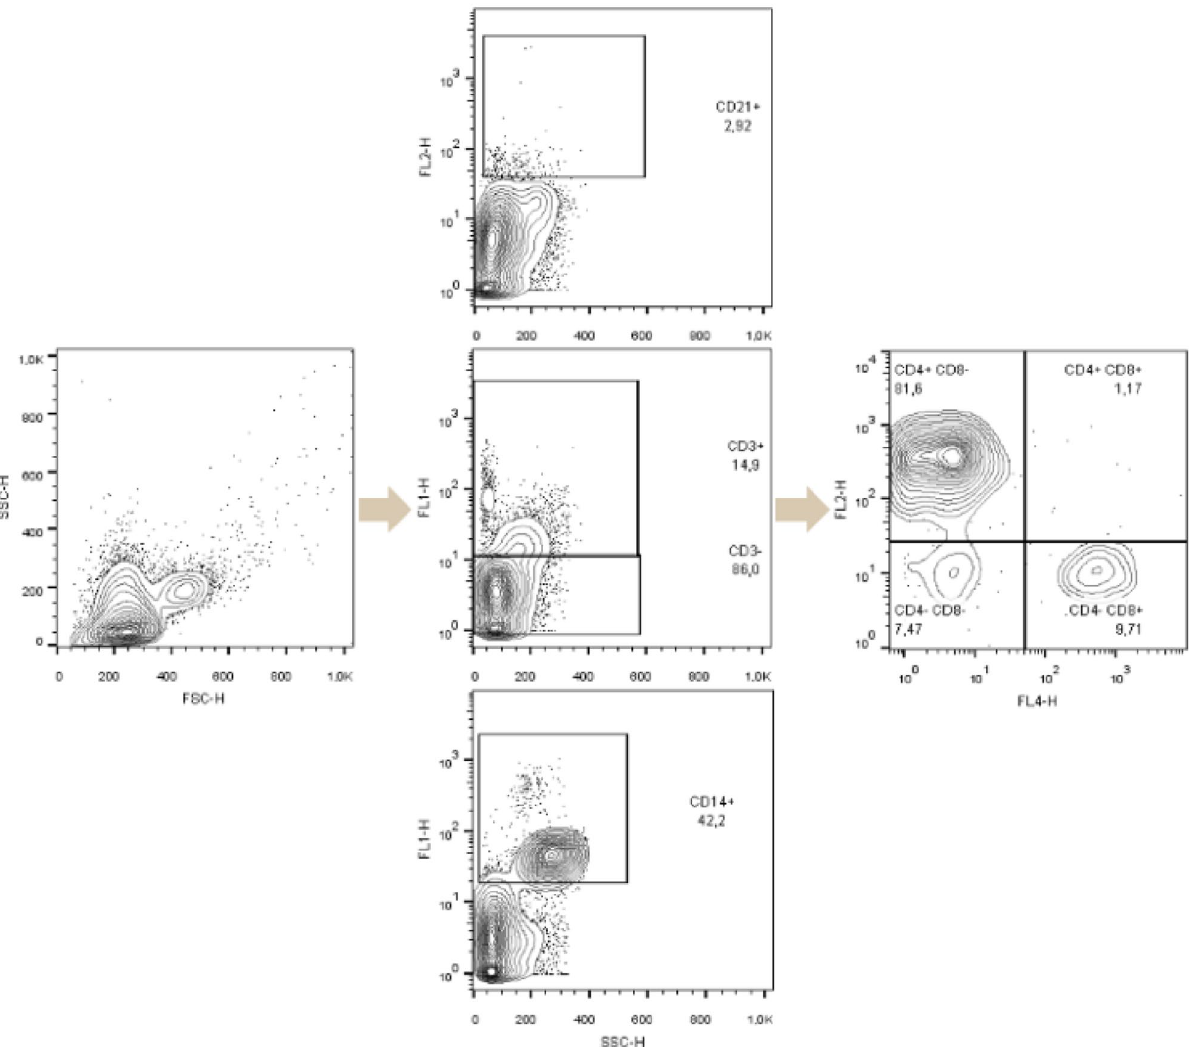
Figure 6. Gating strategy applied to flow cytometry data. Viable cells were selected by FSC and SSC gate. Other gates based on CD3+, CD3−, CD14+ and CD21+ markers were established within viable cell gates.